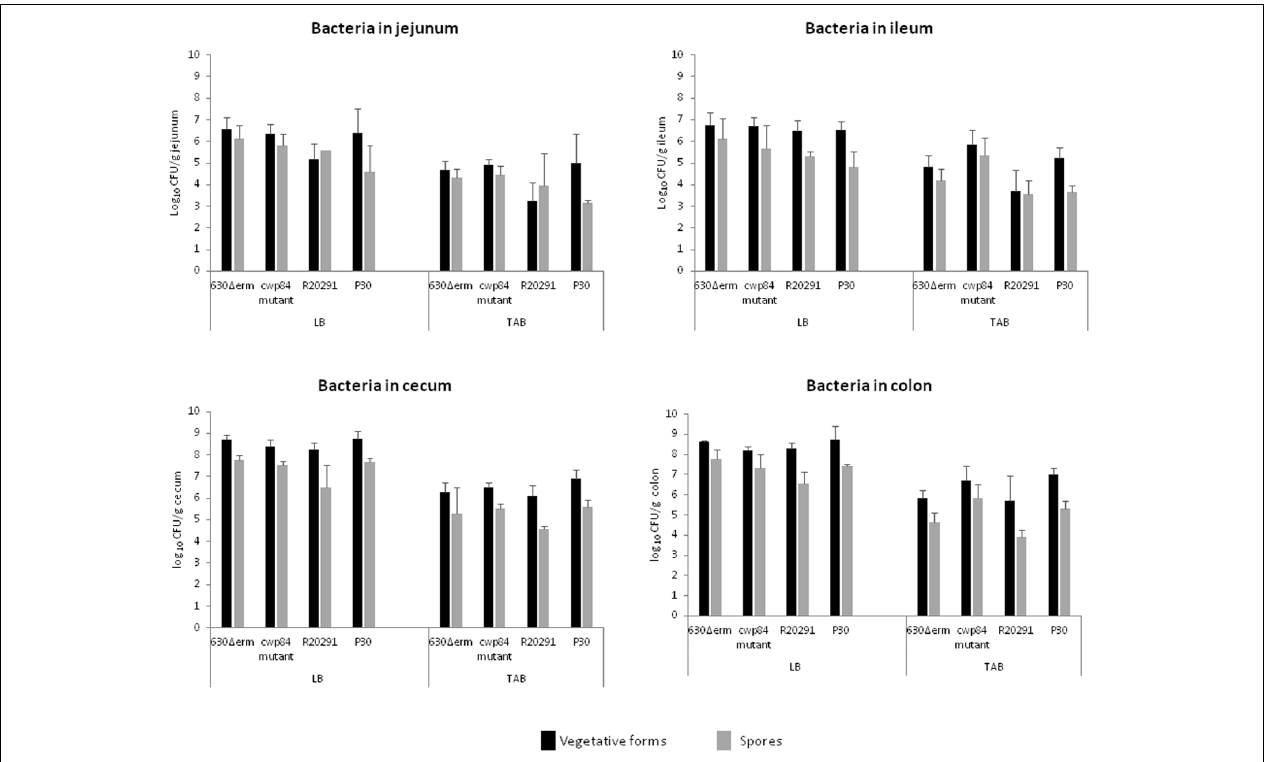
FIGURE 1 | Intestinal colonization of monoxenic mice by Clostridium difficile strains. Quantitation of viable vegetative cells (luminal bacteria, LB and tissue-associated bacteria, TAB) in the different parts of the intestine (jejunum, ileum, cecum, and colon). The data represent the average of three independent assays. No statistical analysis was performed because the number of mice tested was limited to three per